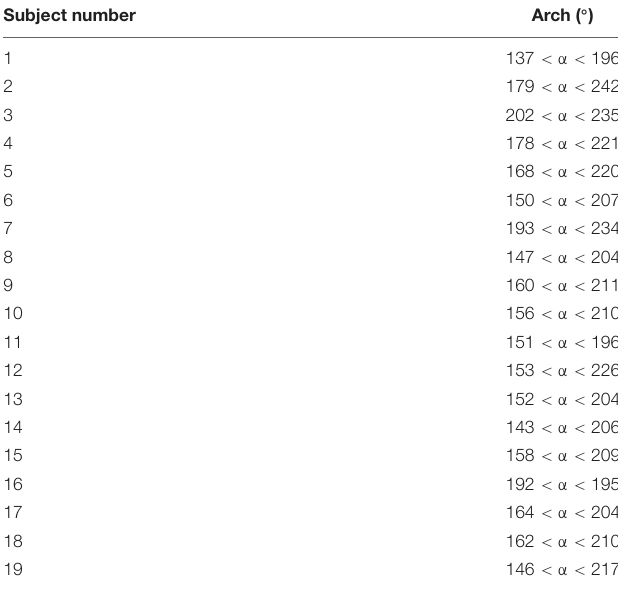
TABLE 1 | Facial feature detection efficacy as a function of the rotation angle referenced to the frontal view.